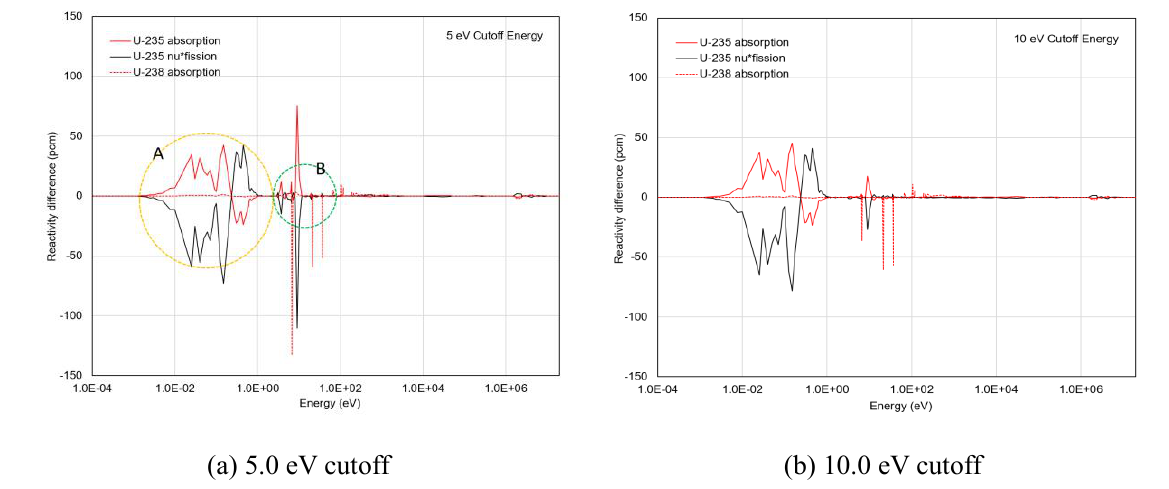
Figure 3. Comparison of reaction rate analysis between 5.0 and 10.0 eV cutoff